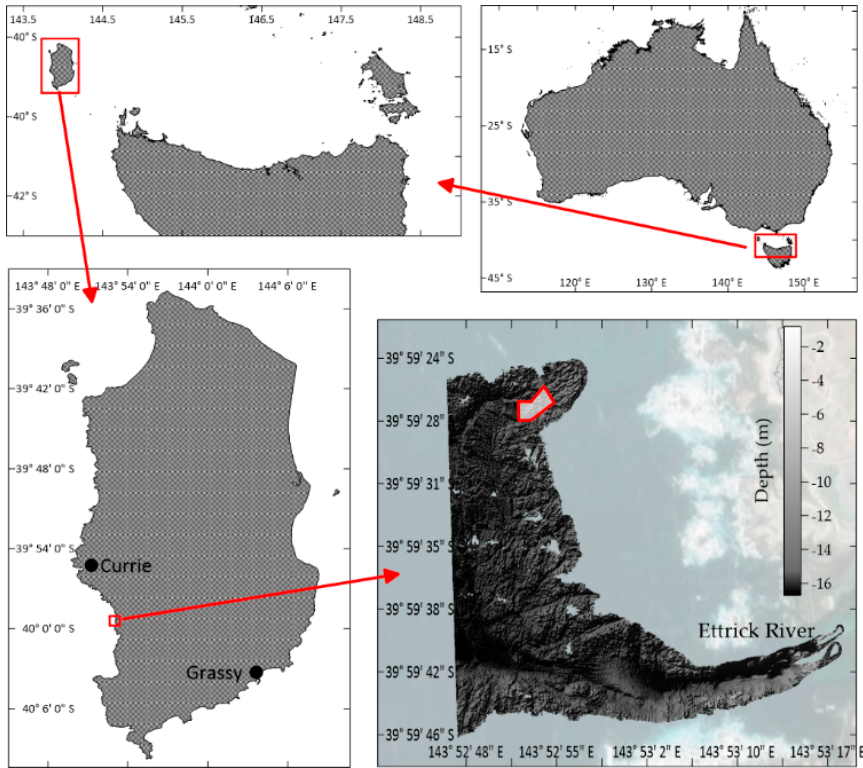
Figure 1. Location of Wave Swell Energy Ltd. survey in the Bass Strait on the west coast of King Island, Tasmania in ~10 m of water and the location of the Ettrick River which is the destination of the cable to the grid.